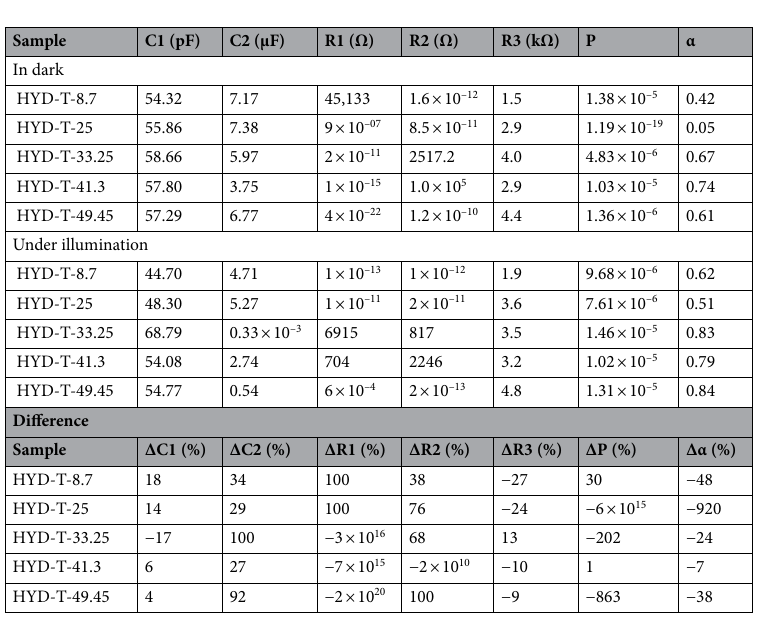
Table 2. Values of the parameters of the electric circuit model obtained from the fitted Nyquist plots for HYD-T materials in darkness, under illumination, and the difference between them.